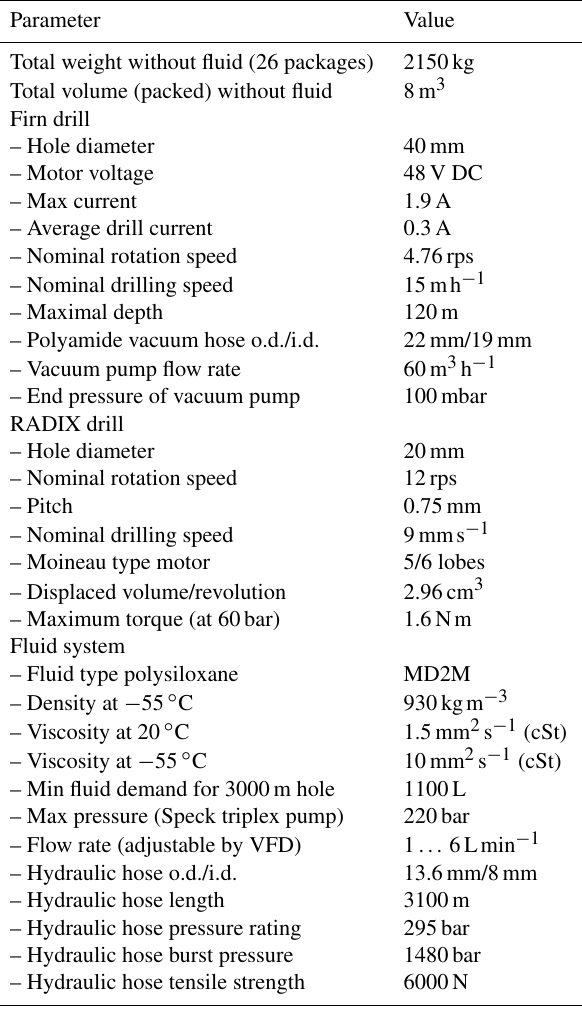
Table 1. RADIX specifications. VFD: variable frequency drive. Parameter Value